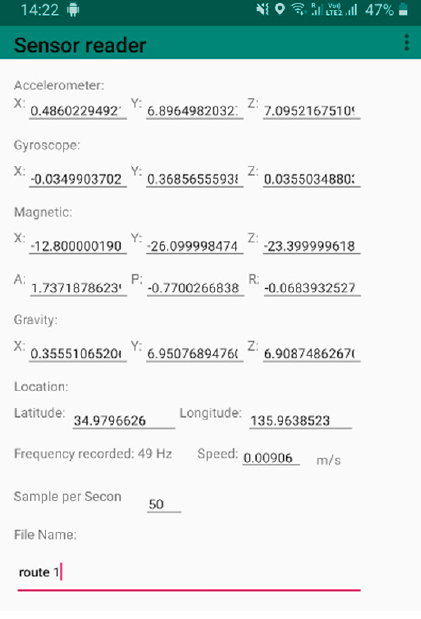
Figure 7. A screenshot of the android application developed for data acquisition. A noised (alternative) dataset was created, using the raw data, as specified by Equation (1) with t = 0.1. The data of this set were segmented and labeled in the same manner as the noise-free